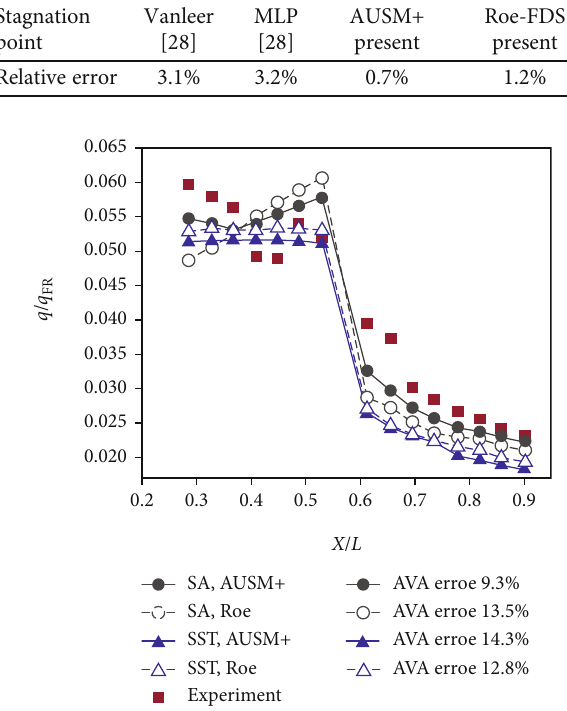
Figure 9: Dimensionless heat fl ux distribution on the surface of blunt Table 5: The stagnation point heat fl ux error.